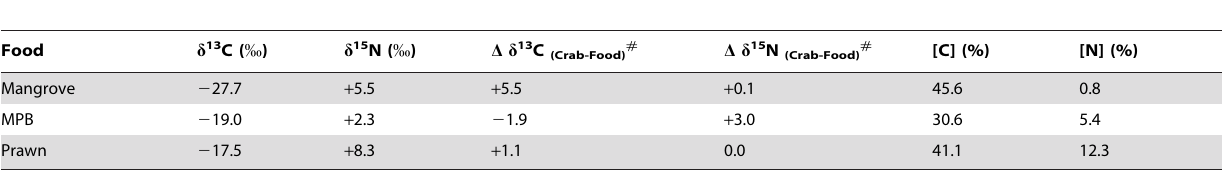
Table 1. Data used in the estimation of relative contributions of mangrove leaf, MPB and animal tissue in the diet of P. erythodactyla using the IsoConc mixing